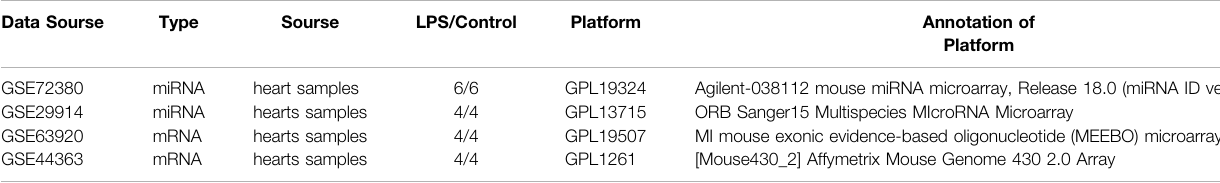
TABLE 2 | Characteristics for GEO microarray in LPS hearts tissues. Data Sourse